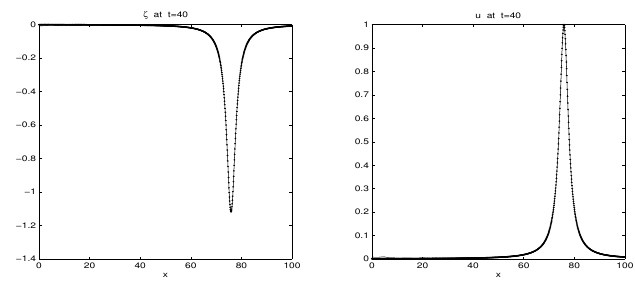
Figure 5. In points: approximate solitary wave solution (5.30)–(5.31). In solid line: solution ( ζ num ,u num ) obtained with the numerical solver.